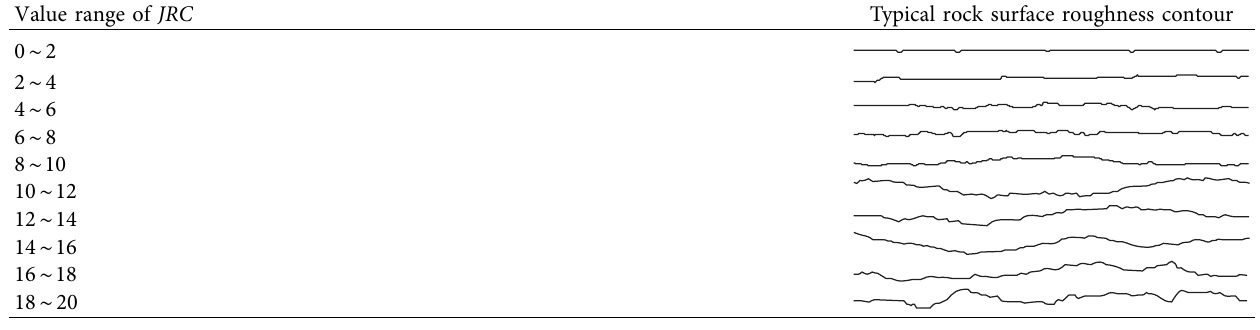
Table 2: Barton standard roughness contours.